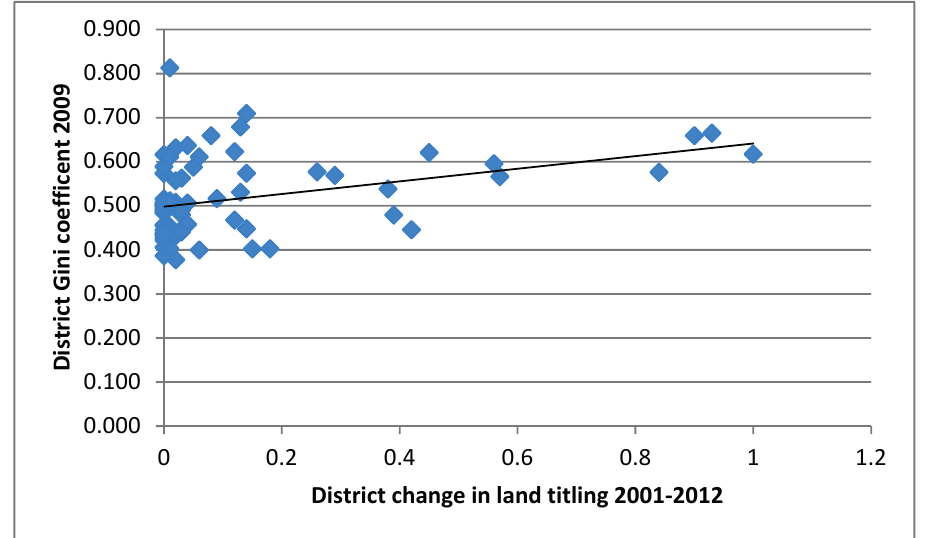
Figure 7. Scatter plot of District-level changes in Gini Coefficients, 2009, and Changes in Land Titling 2001-2012. Sources: CFS 2009, Supplemental Survey 2001 and RALS